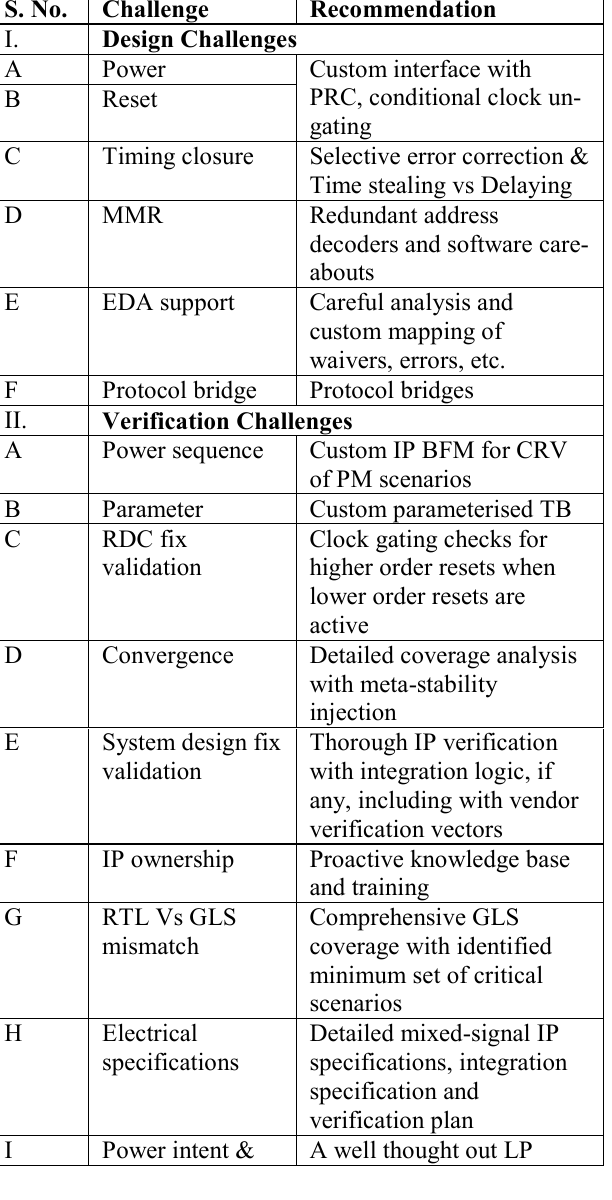
Table 1. Summary of challenges and